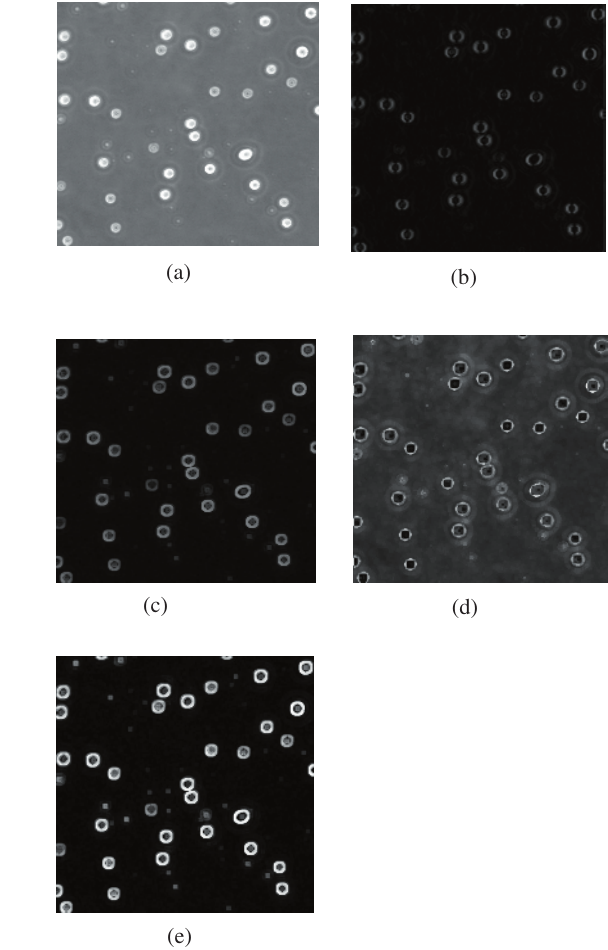
Fig. 7. : a) blood cell image, b) edge image using fuzzy morphology, c) edge image using the interval valued fuzzy set, d) edge image by Chaira and Ray , e)